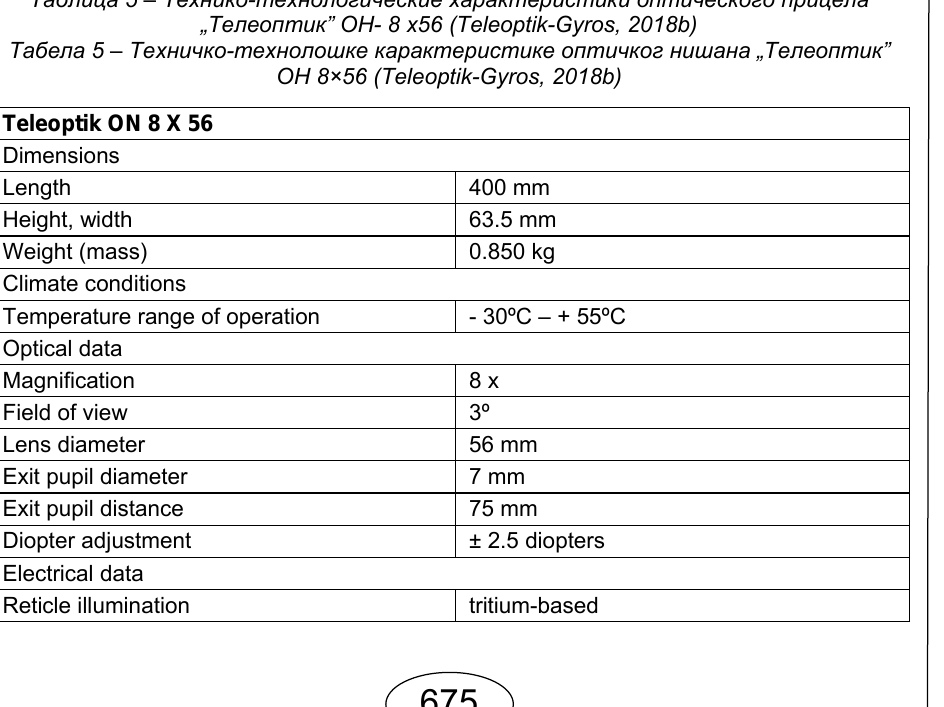
Table 5 – Technical-technological characteristics of the Teleoptik ON 8 x 56 optical